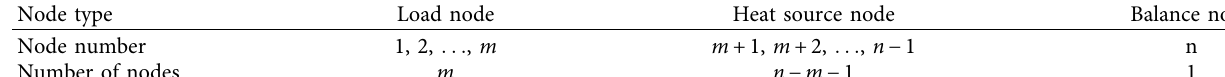
Table 3: Node number of the thermal